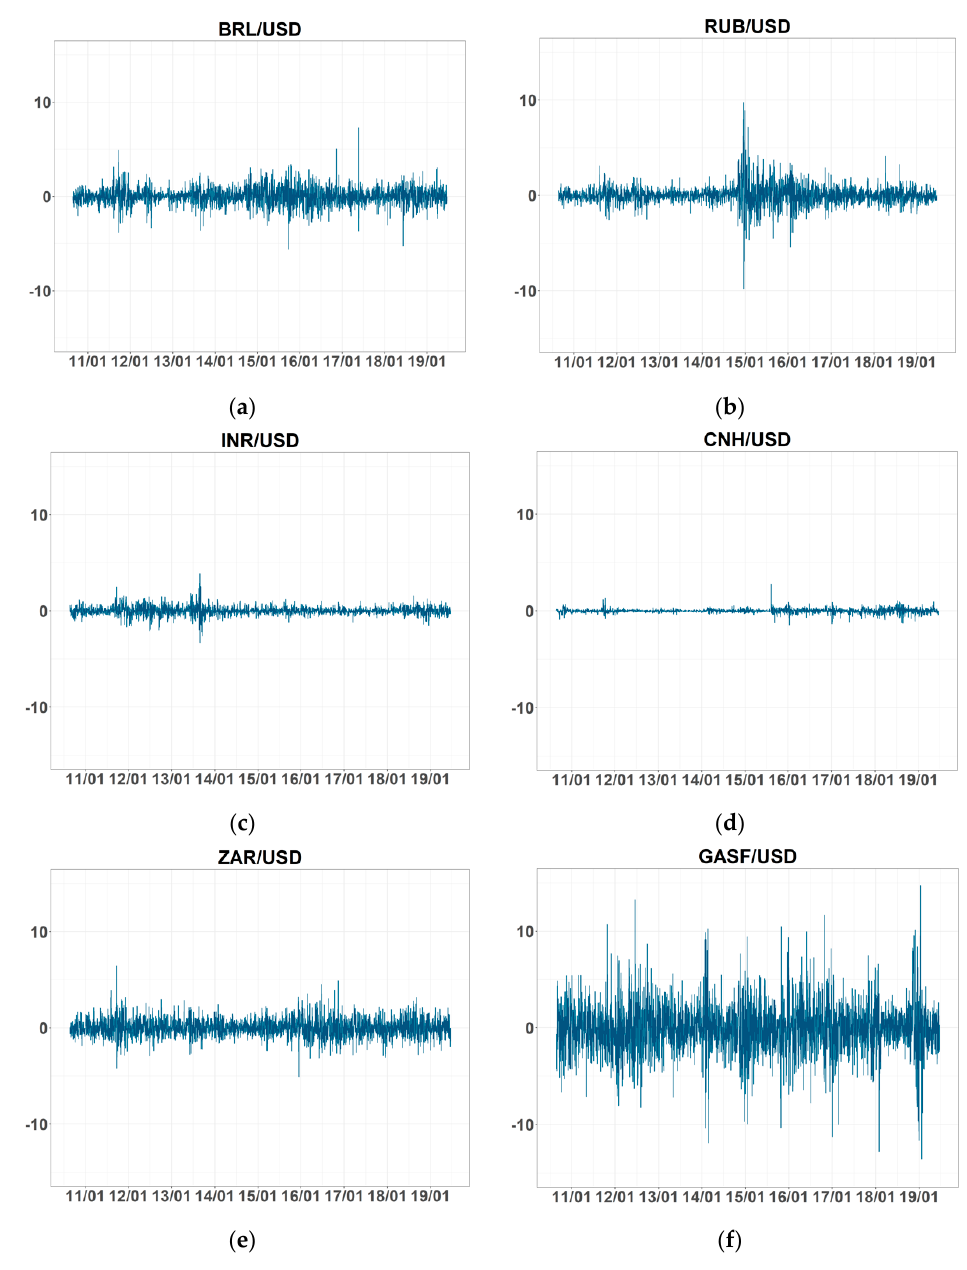
Figure 1. Daily return. Note: BRL, RUB, INR, CNH, and ZAR are Brazilian Real, Russian Ruble, Indian Rupee, offshore Chinese Yuan, and South African Rand, respectively. GASF is the Henry Hub natural gas futures price. ( a – f ) refer to BRL, RUB, INR, CNH, ZAR, and GASF return series, respectively. Table 2. Summary statistics for daily returns.